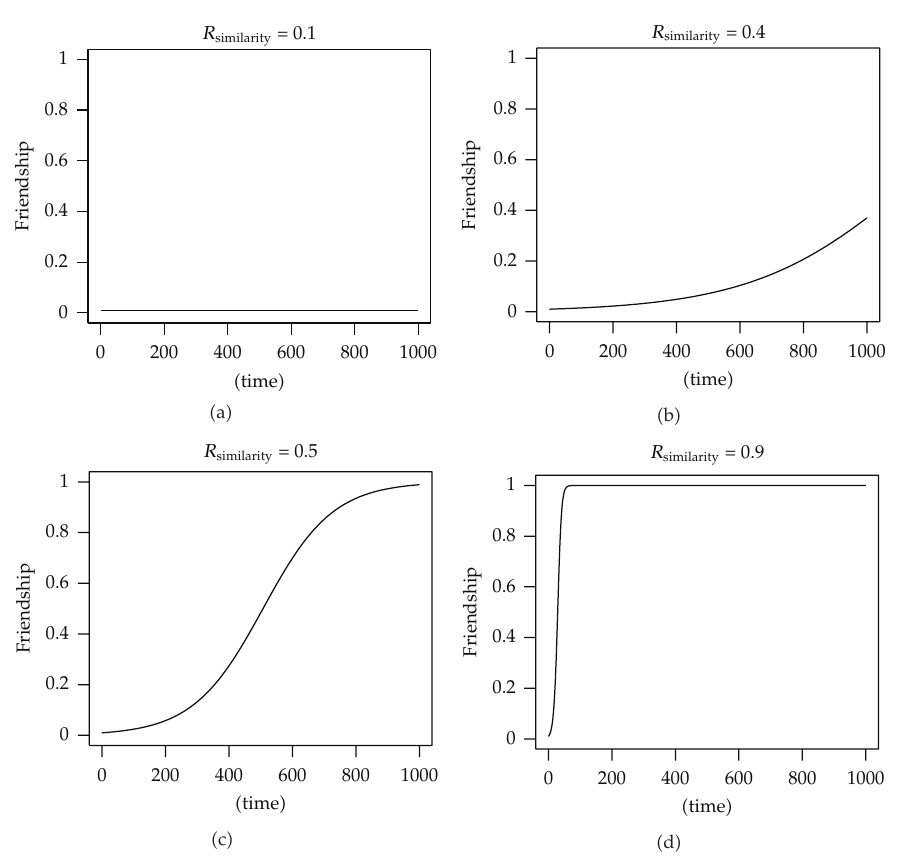
Figure 4: The logistic function chosen for the evolution of friendship, for several one-to-one R similarity